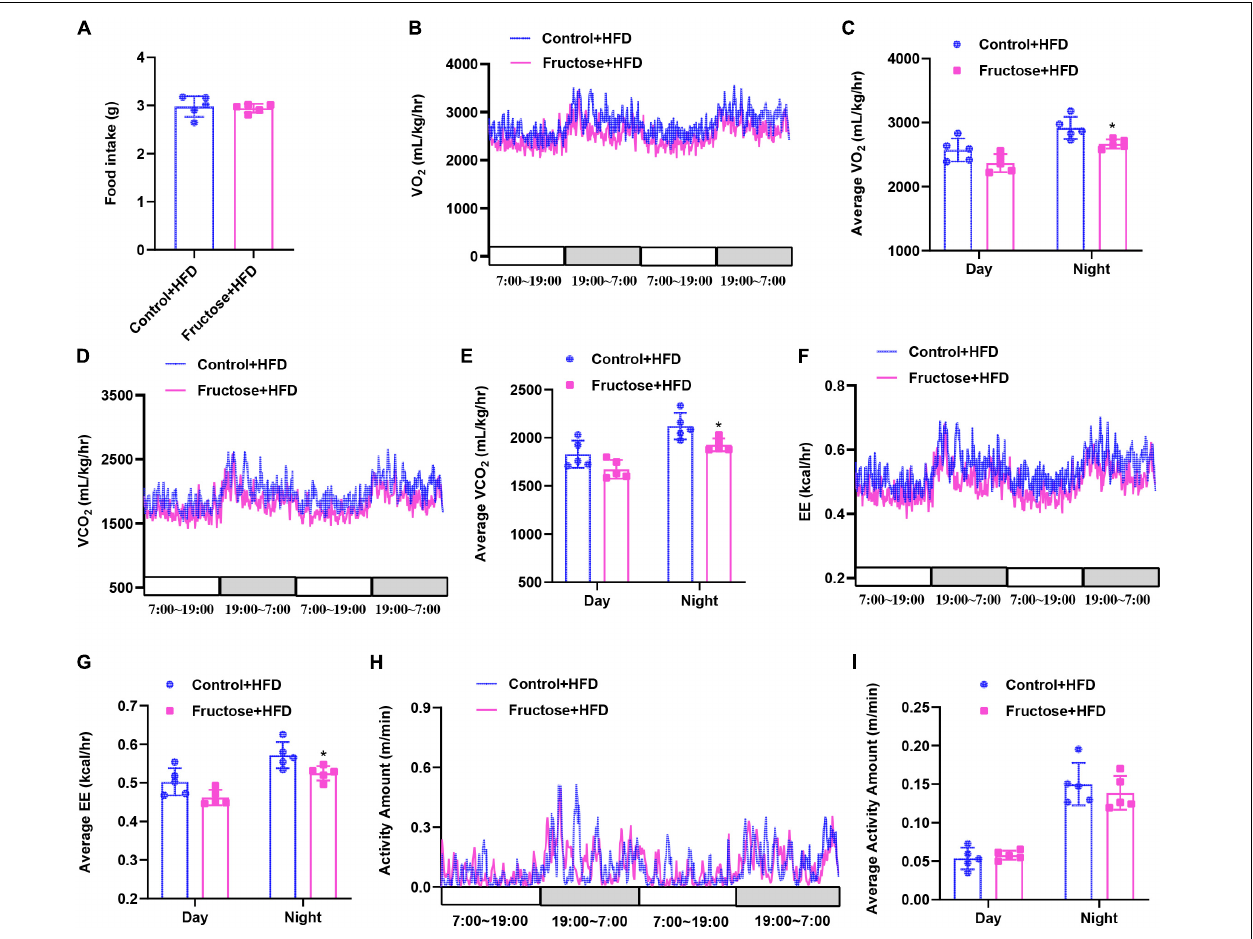
FIGURE 3 | High-fat diet-induced energy expenditure is impaired in adult offspring of dams fed with high fructose. All data were from the 17-week-old HFD-fed control offspring and HF offspring. (A) Daily food intake of the mice ( n = 5). Indirect calorimetry analysis of day and night oxygen consumption (VO 2 , B,C ), carbon dioxide production (VCO 2 , D,E ), heat production (F,G) , and physical activity (H,I) of the mice ( n = 5). * p <